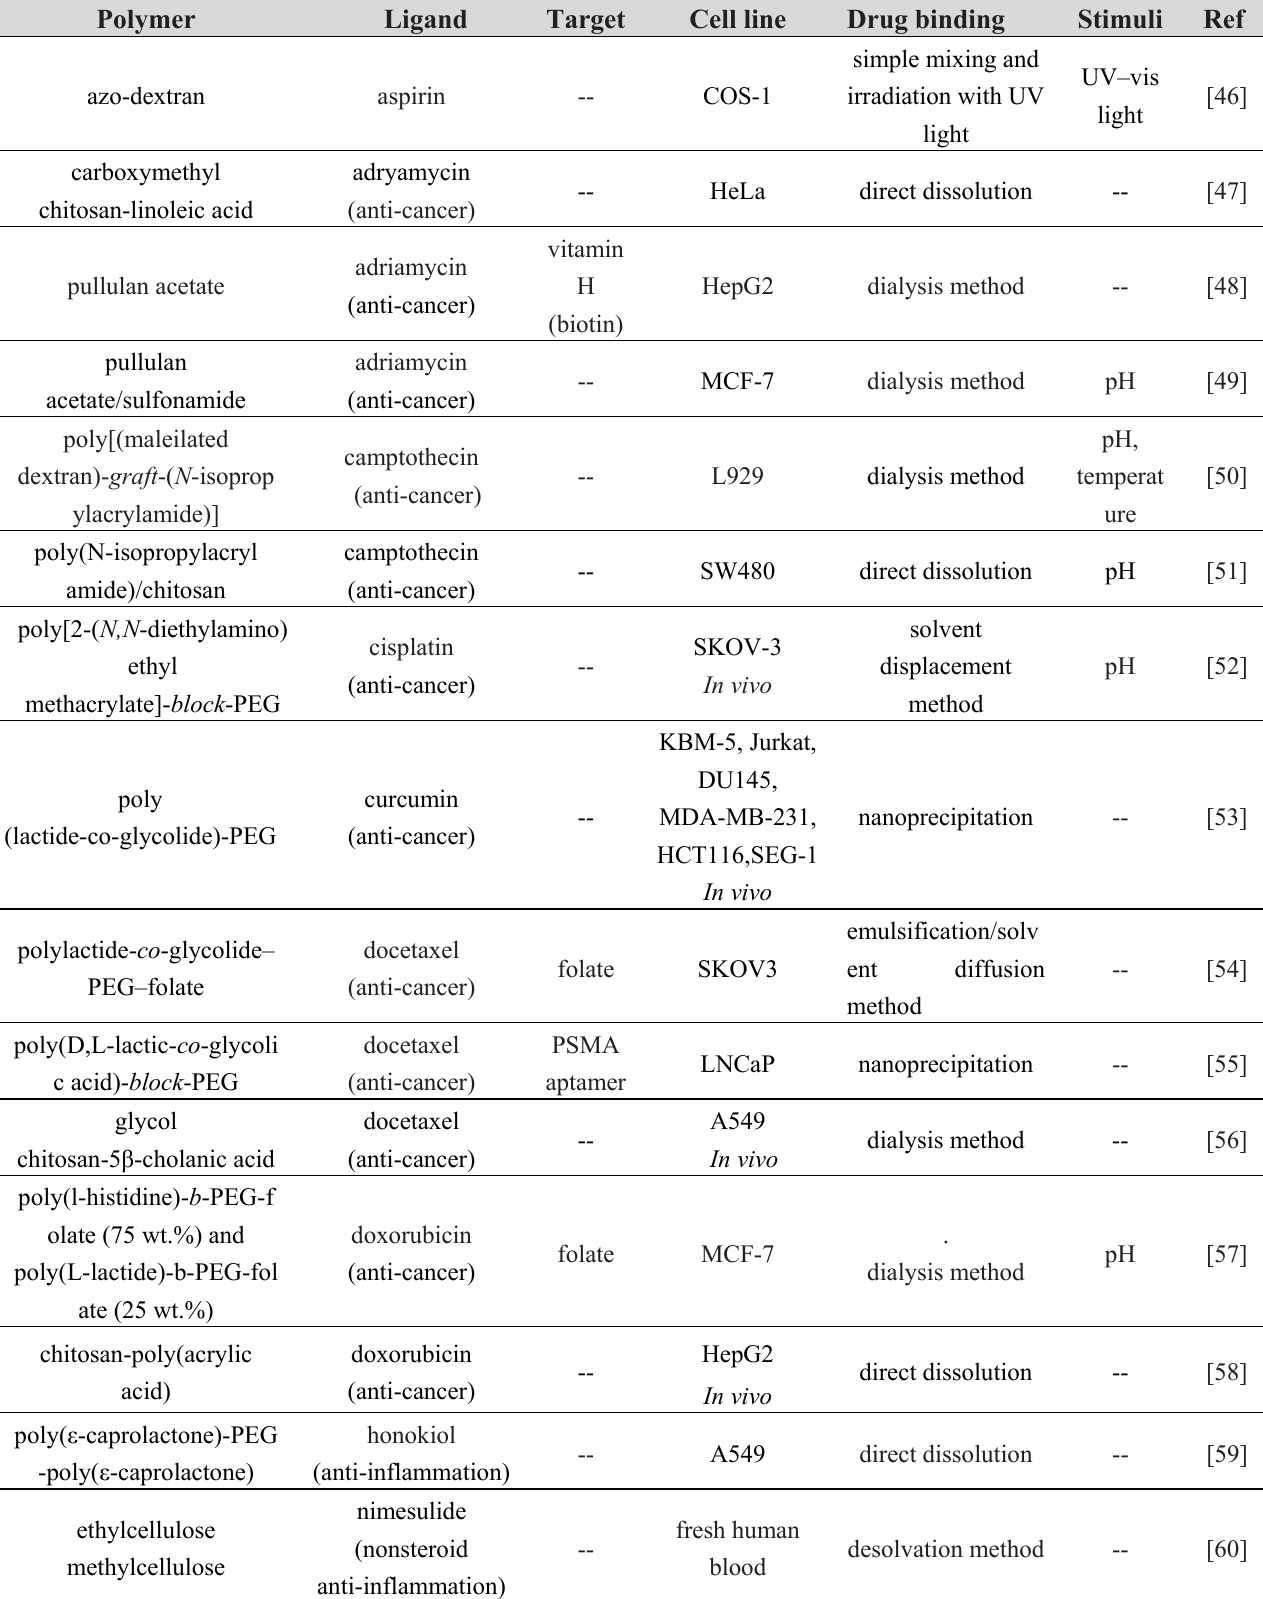
Table 1. Nano-carriers for small molecular weight drug